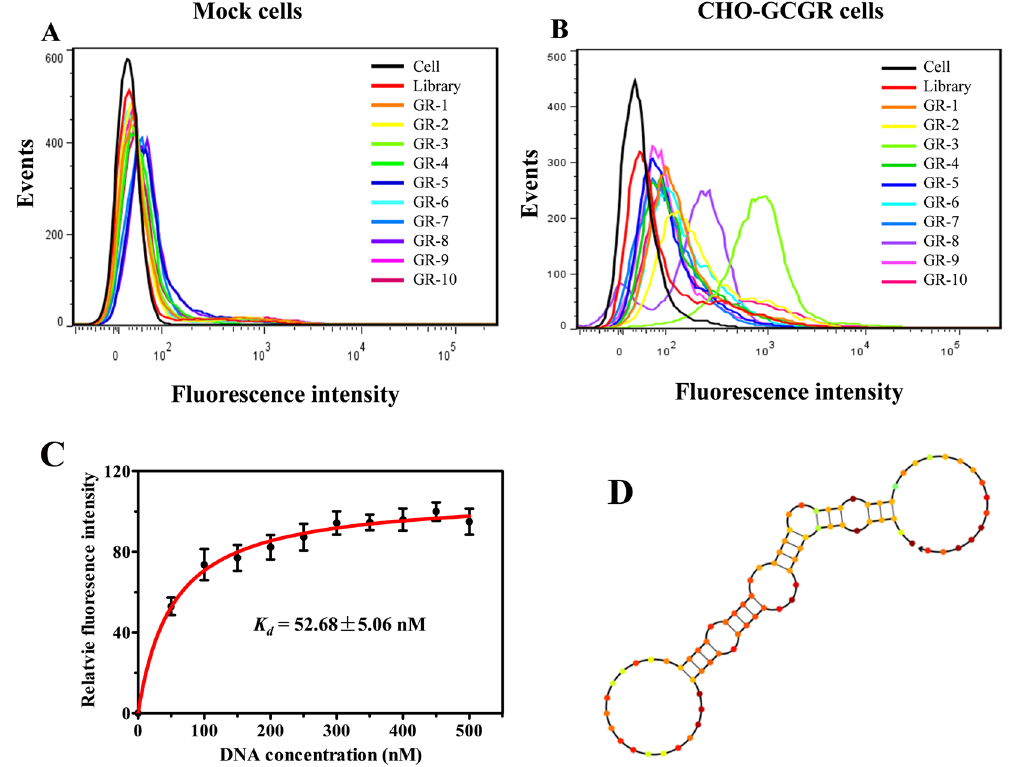
Figure 3. Binding assay of aptamer candidates. The binding ability of aptamer candidates to ( A ) Mock cells and ( B ) CHO-GCGR cells was analyzed by flow cytometry. The black curve represents the background fluorescence of untreated cells. The unselected initial ssDNA library was used as negative control. ( C ) Dissociation constant ( K d ) of GR-3 for CHO-GCGR cells was measured by flow cytometry. ( D ) Secondary structure of GR-3 predicted by